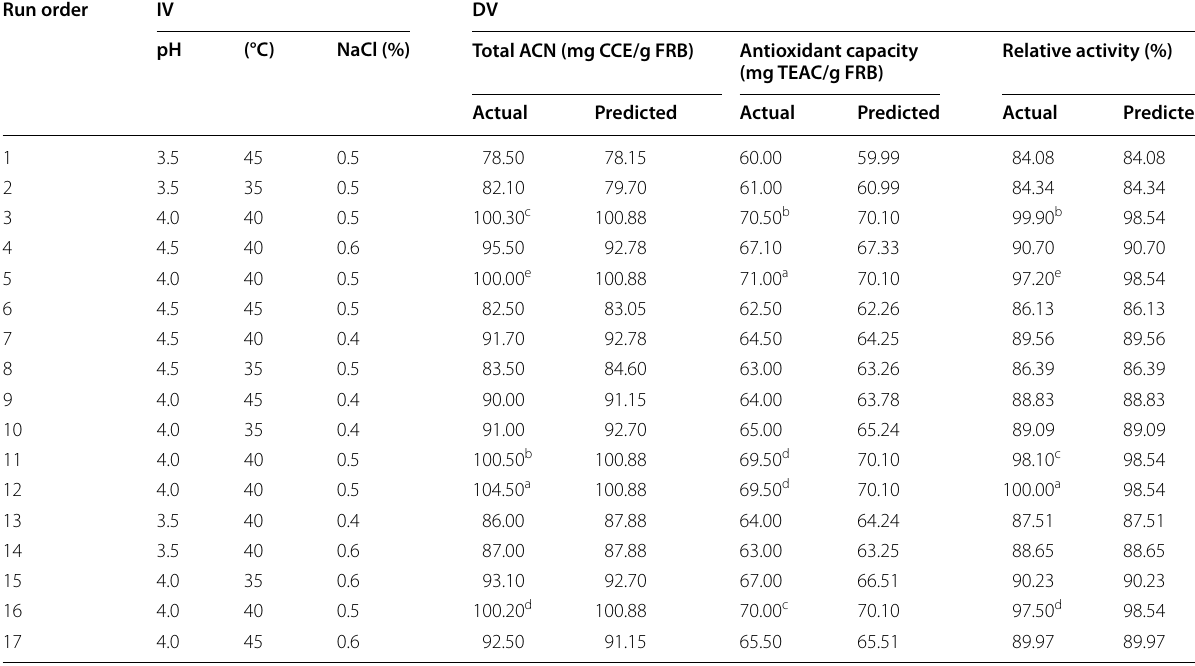
Table 1 The predicted and actual values of ACN content, antioxidant capacity of FRB and BGS activity during fermenta- tion